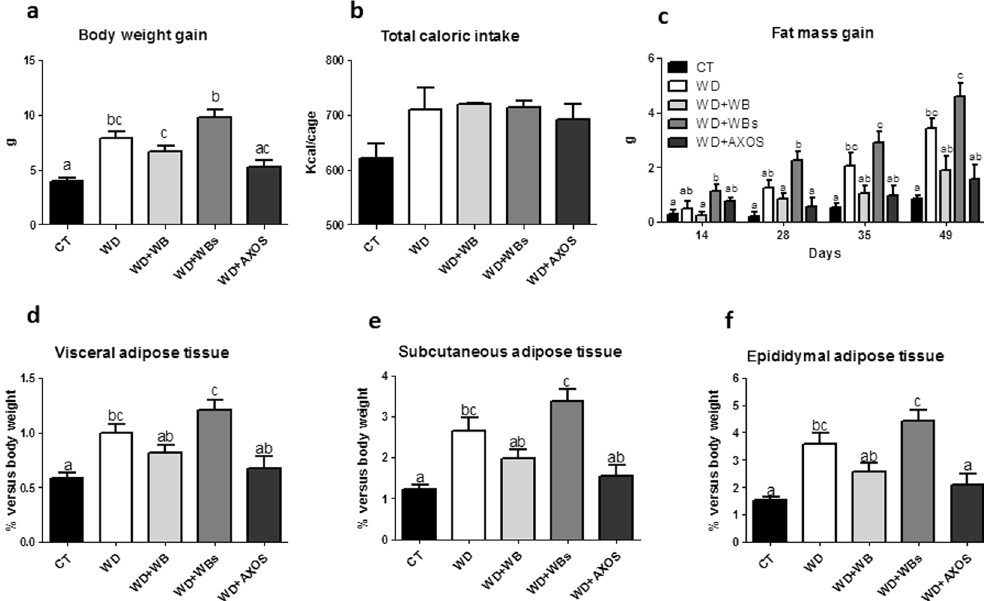
Figure 5. Impact of the three cereal fractions on obesity, dietary intake and fat mass development. Body weight gain ( a ), total caloric intake ( b ), fat mass gain measured by NMR at days 14, 28, 35 and 49 ( c ), weight of visceral adipose tissue ( d ), weight of subcutaneous adipose tissue ( e ), weight of epididymal adipose tissue ( f ). Mice were fed a control diet (CT), a western diet (WD), a WD supplemented with 5% of wheat bran fraction with large particles (WD + WB), a WD supplemented with 5% of wheat bran with reduced particle size (WD + WBs) or a WD supplemented with 5% of AXOS (WD + AXOS) for 8 weeks. Results are expressed as mean ± SEM (n = 7–9 for a , c – f and n = 2–3 for b ). Data with different superscript letters are significantly different at p < 0.05